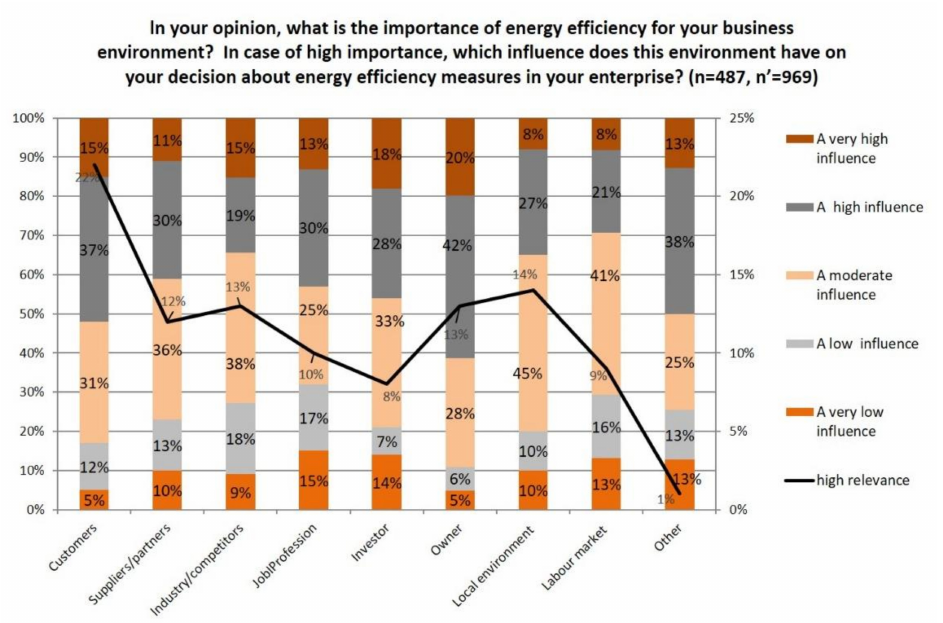
Figure 11. The perception of the importance of energy e ffi ciency for the environment of the